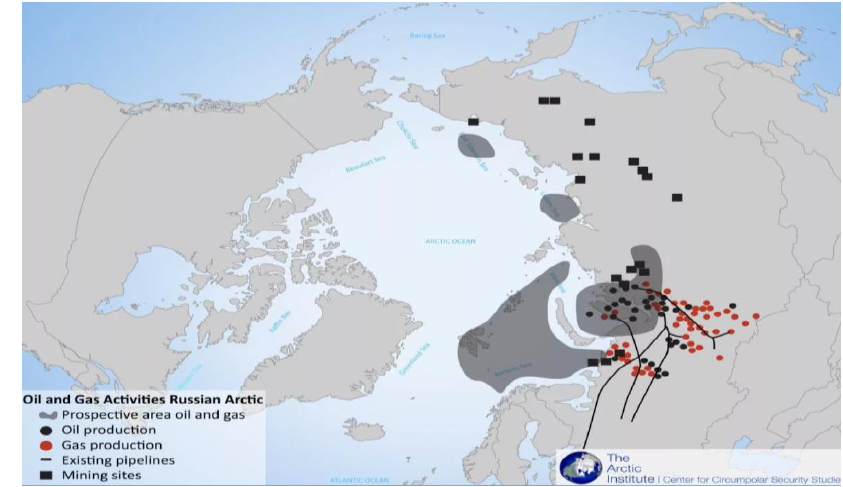
Figure 1. Russia’s energy assets in the Arctic.